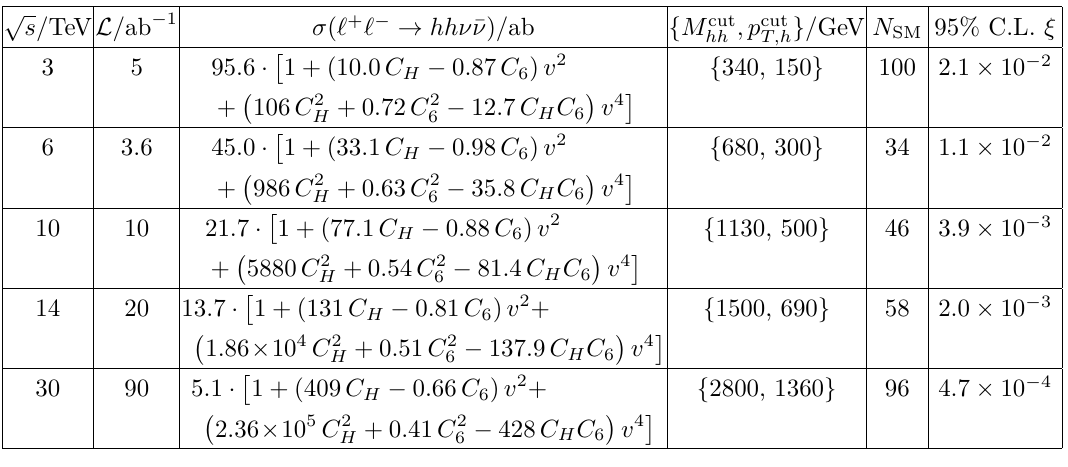
Table 8 . High-mass σ ( ‘ + ‘ − → hhνν ) in ab at various high energy lepton colliders as a function of the new physics couplings C H and C 6 , normalized with v = 246 GeV. The cross-sections are calculated in the high invariant mass region defined by the cuts given in the fourth column, and requiring η h < 2 . We also report the total number of SM h → jj events, and the corresponding 95% C.L. bound on the parameter ξ ≡ C H v 2 ( C H > 0 ), calculated assuming a di-Higgs reconstruction efficiency (cid:15) sig = 30% for boosted hadronic Higgs